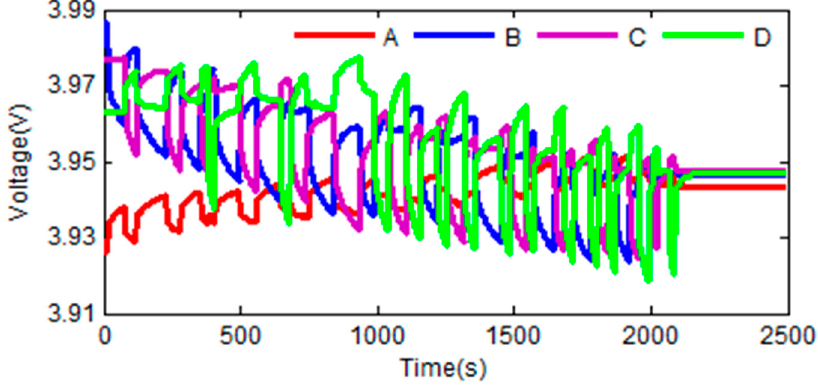
Figure 9. Four cells’ voltage waveforms in the equalization process.